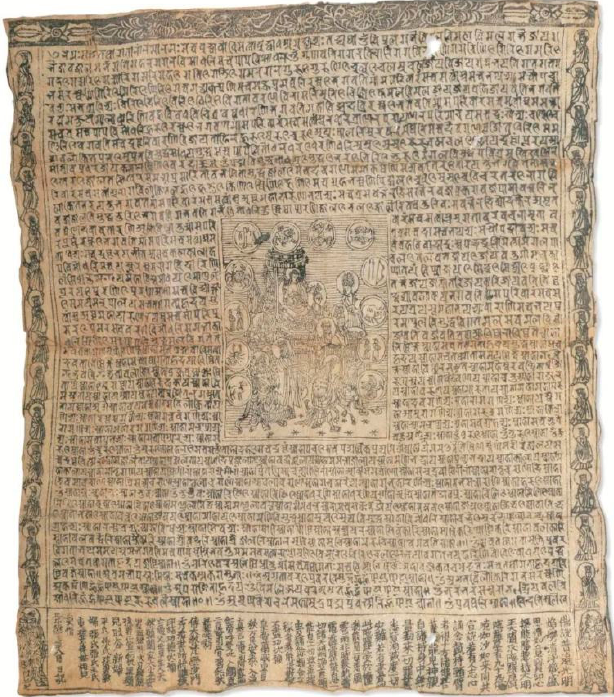
Figure 6. Dasuiqiu tuoluoni jing 大 隨 求 陀 羅 尼 經 (Tejaprabh¯a sutra) arranged in Sanskrit letters. For- merly sealed inside Ruiguangsi pagoda crypt, now collection of Suzhou Museum, China. Woodblock print, 25 cm × 21.2 cm, Dated 1005.